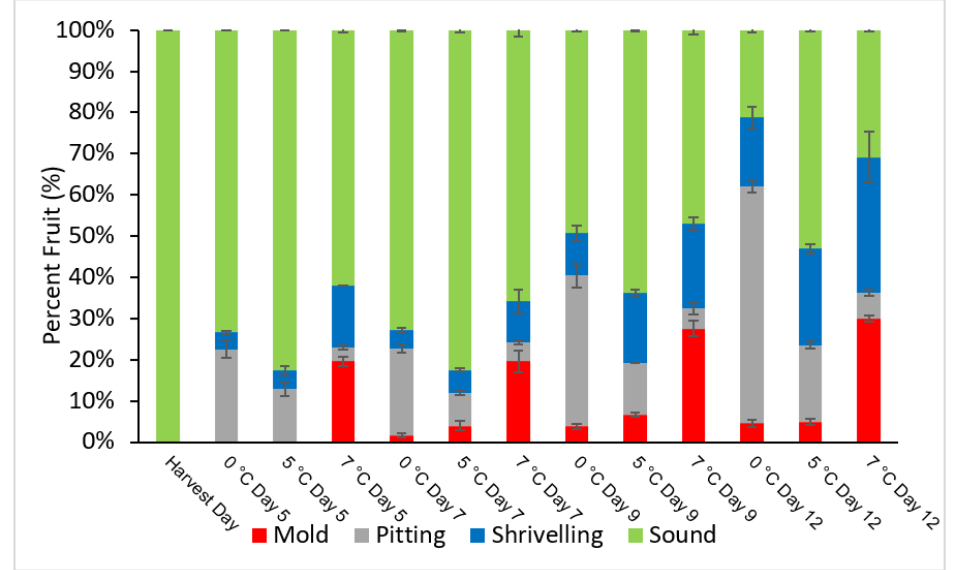
Figure 1. Distribution of fruit alteration types during the storage of goji berries.